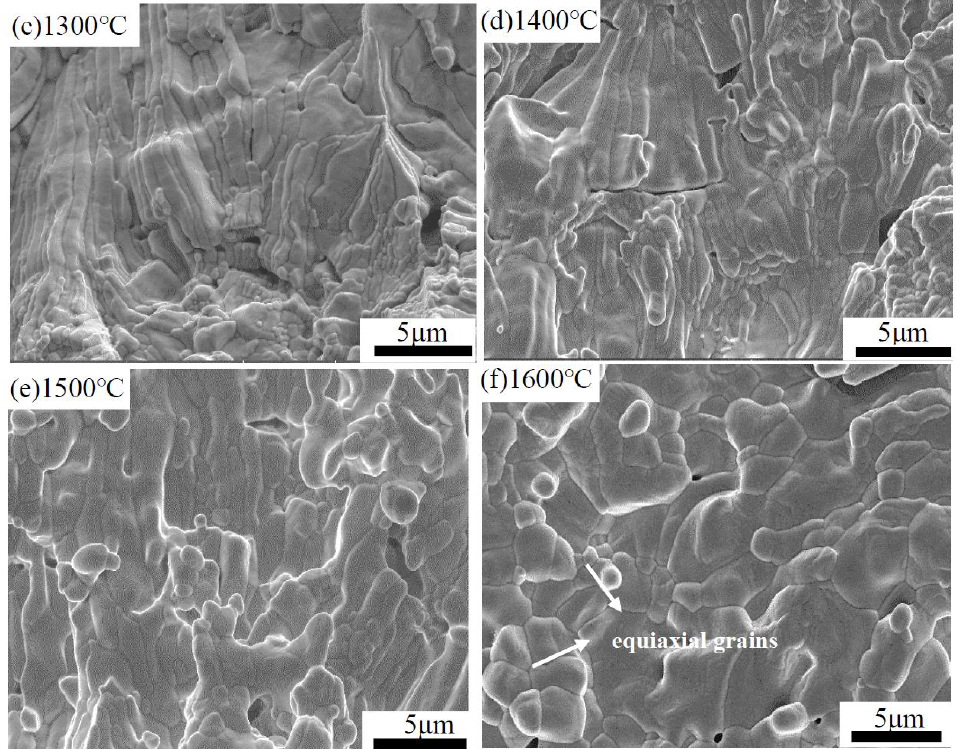
Figure 6. Fracture morphologies of YSZ top coatings before and after thermal aging at different temperatures. ( a ) as-sprayed; ( b ) at 1200 °C for 24 h; ( c ) at 1300 °C for 24 h; ( d ) at 1400 °C for 24 h; ( e ) at 1500 °C for 24 h; ( f ) at 1600 °C for 24.